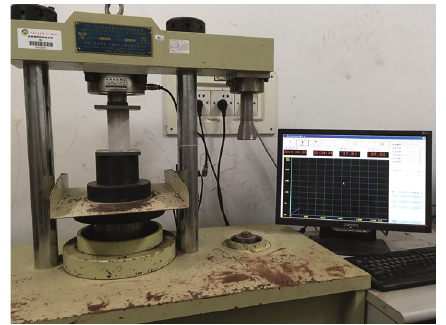
Figure 8: TYE-300D type test machine.